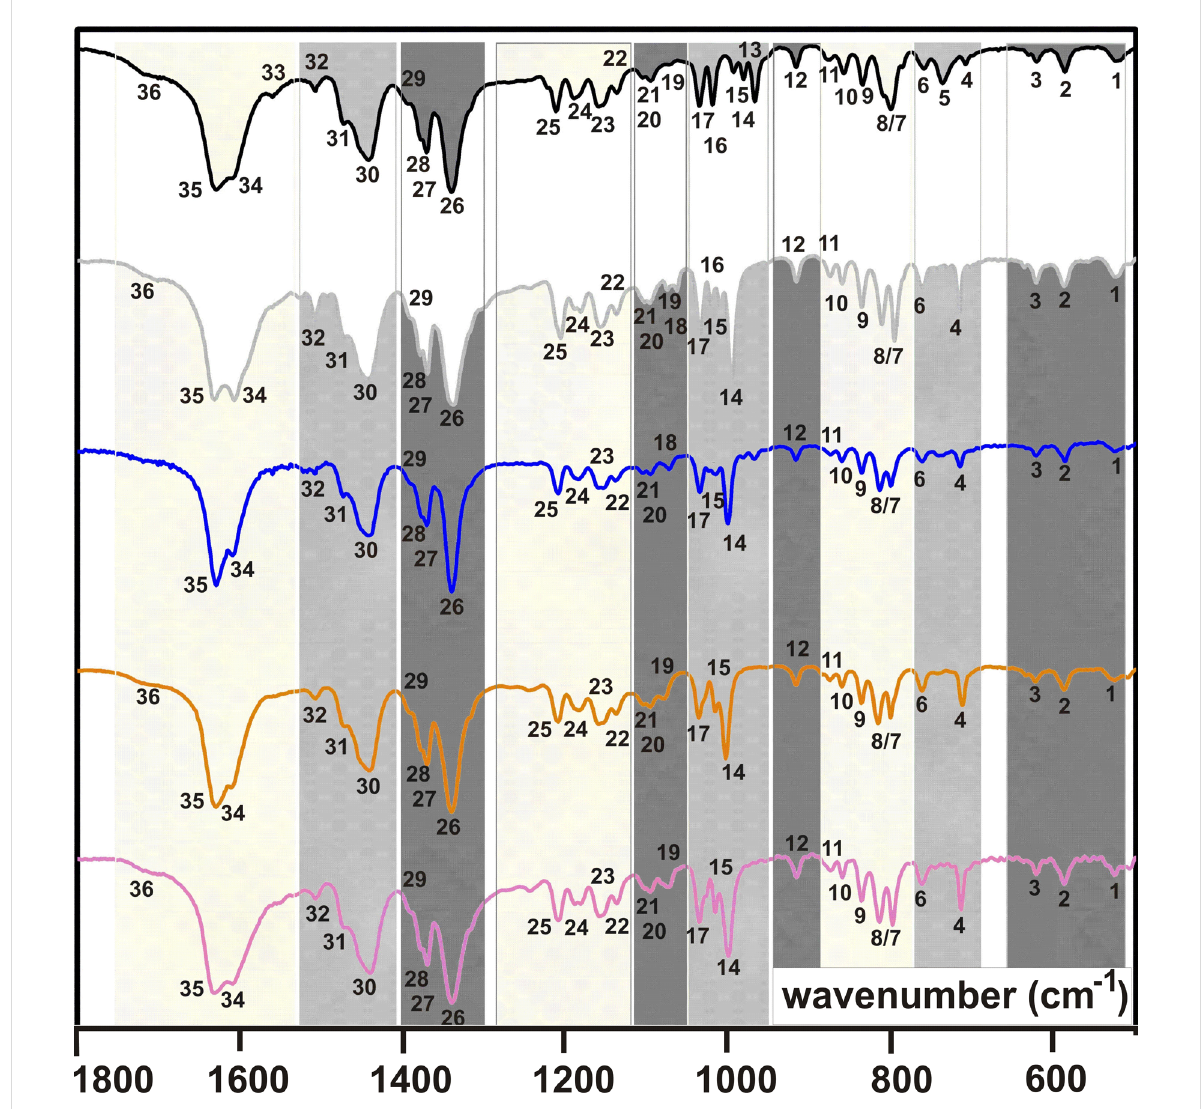
Figure 3: IR spectra (KBr) in the range of 500–1800 cm − 1 for H 2 TPP(CON(iPr) 2 ) 4 ( 3 , top) and MTPP(CON(iPr) 2 ) 4 (M II = Zn, 3a (gray); Cu, 3b (blue); Ni, 3c (orange); Co, 3d (purple)).